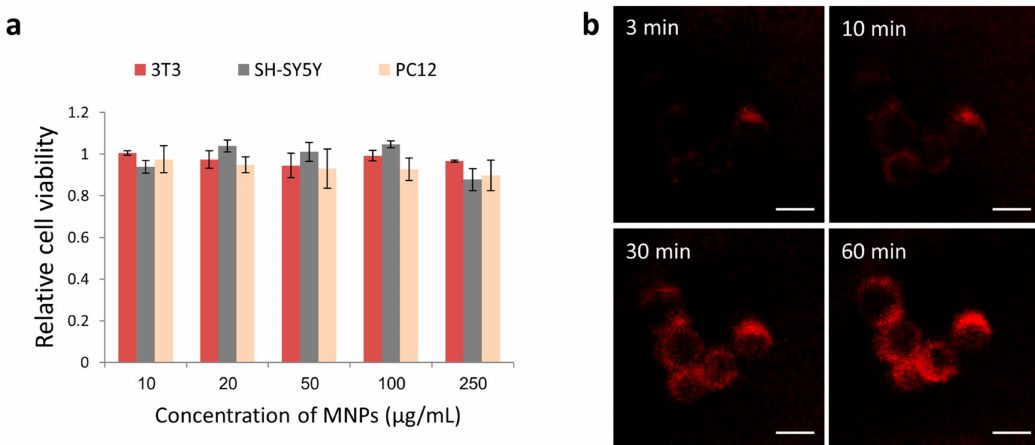
Figure 2. ( a ) XTT viability assay of 3T3, SH-SY5Y, and PC12 cells incubated with various concentrations of NGF-MNPs after 24 h ( n = 3); ( b ) Fluorescent images PC12 cells incubated with NGF-MNPs at different time points. Scale bar = 10 µ